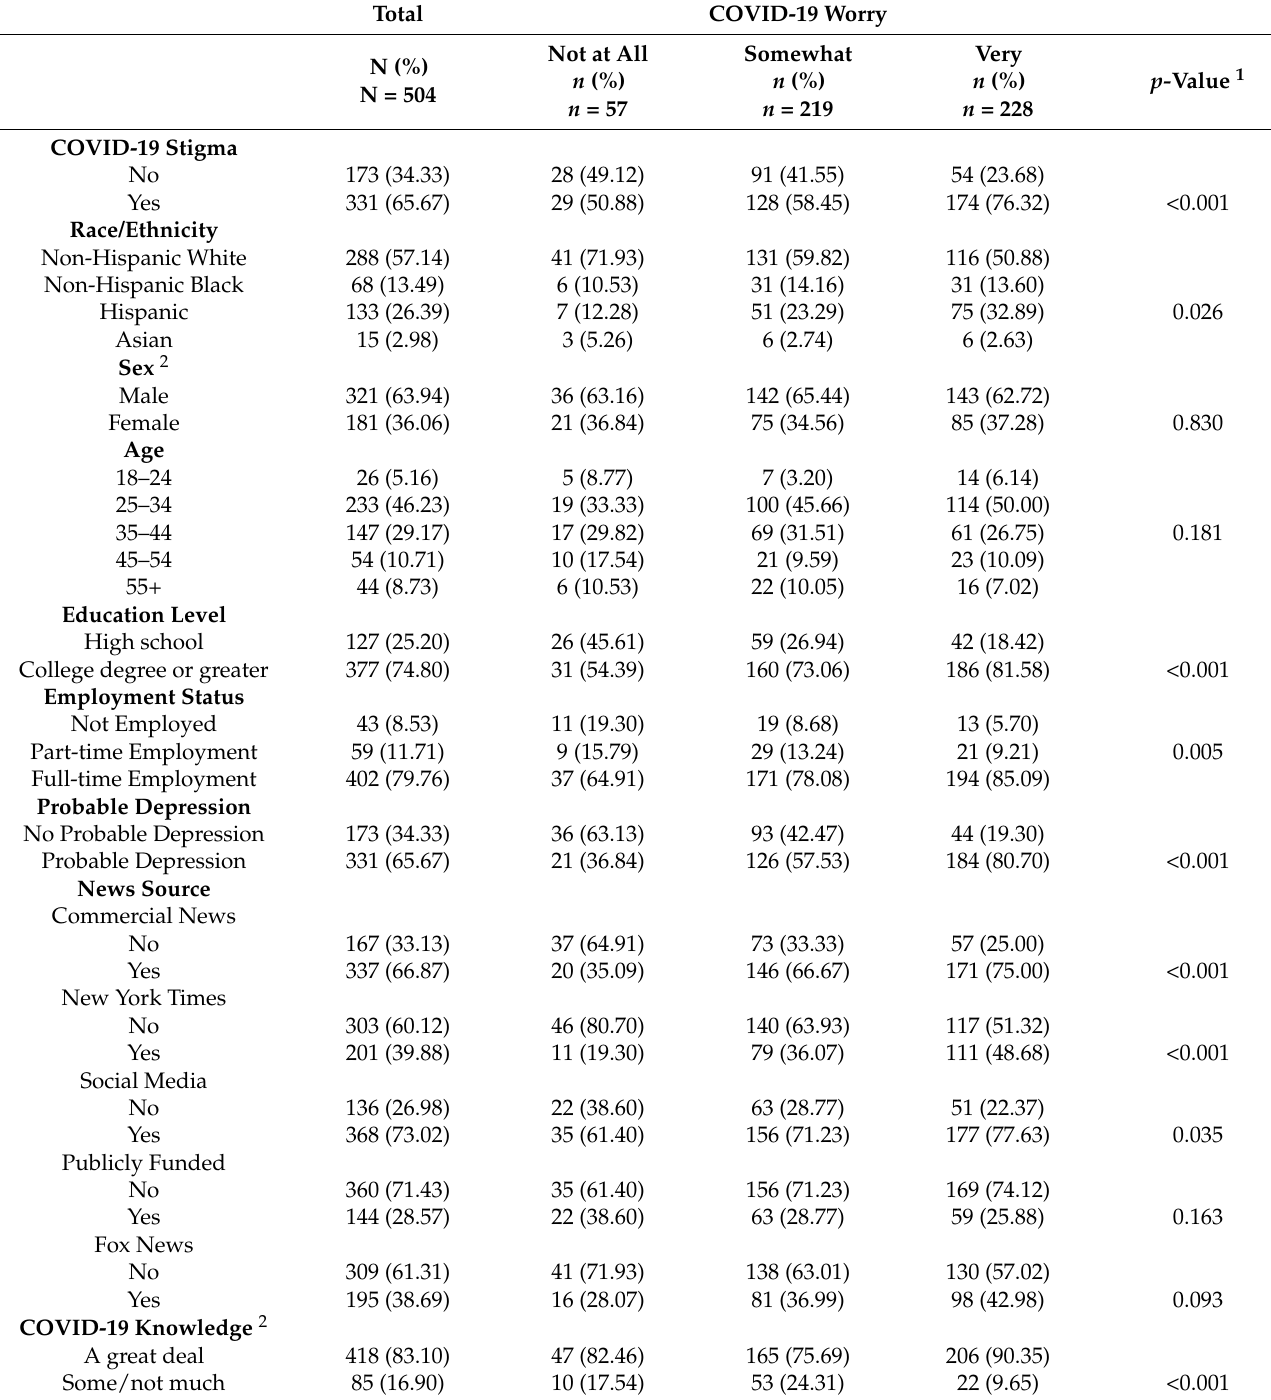
Table 2. Associations between MTurk worker characteristics and COVID-19 worry, National, N =